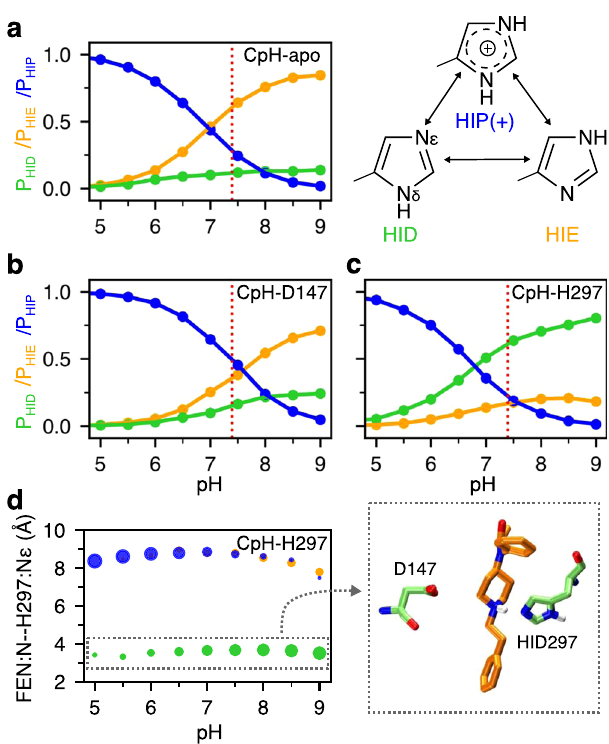
Fig. 3 Protonation state of His297 is in fl uenced by fentanyl binding. a – c Occupancies of the HID (green), HIE (orange), and HIP (blue) states of His297 as a function of pH from the replica-exchange CpHMD simulations of the apo mOR ( a ) and fentanyl-bound complex in the D147- ( b ) and H297-binding mode ( c ). The three states are in equilibrium through protonation/deprotonation and tautomerization. d Average distance between the piperidine nitrogen and His297 ’ s N ϵ at different pH conditions when His297 is in the HID (green), HIE (orange), or HIP (blue) state. The area of the data point is proportional to the occupancy of the protonation state. A zoomed-in snapshot corresponding to the HID state is